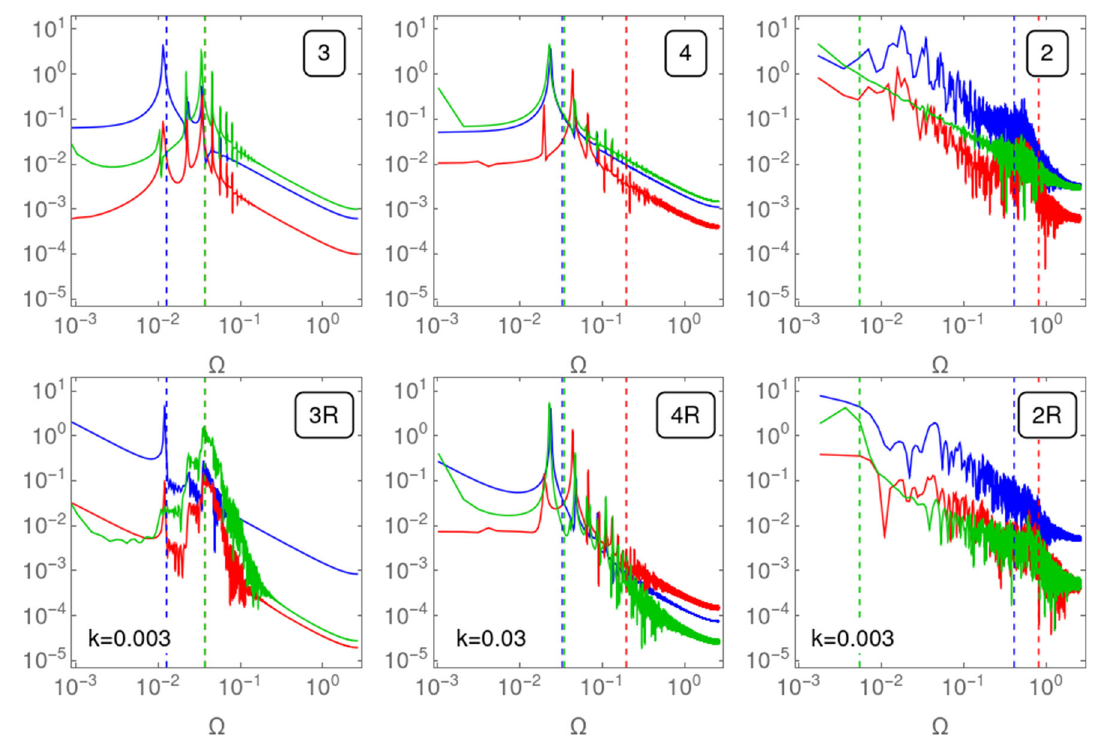
Fig. 16 Power spectral density for three r (τ) (blue), θ(τ) (red) and φ(τ) (green) coordinates along the particle’s trajectory. Fundamental frequencies calculated analytically for circular orbit and presented in Figs. 14 and 15 are plotted as vertical dashed lines. The top row of figures corresponds to trajectories without RR k = 0, see, also Figs. 6 and 7. Cases 3 and 4 represent regular trajectories around off- and in-